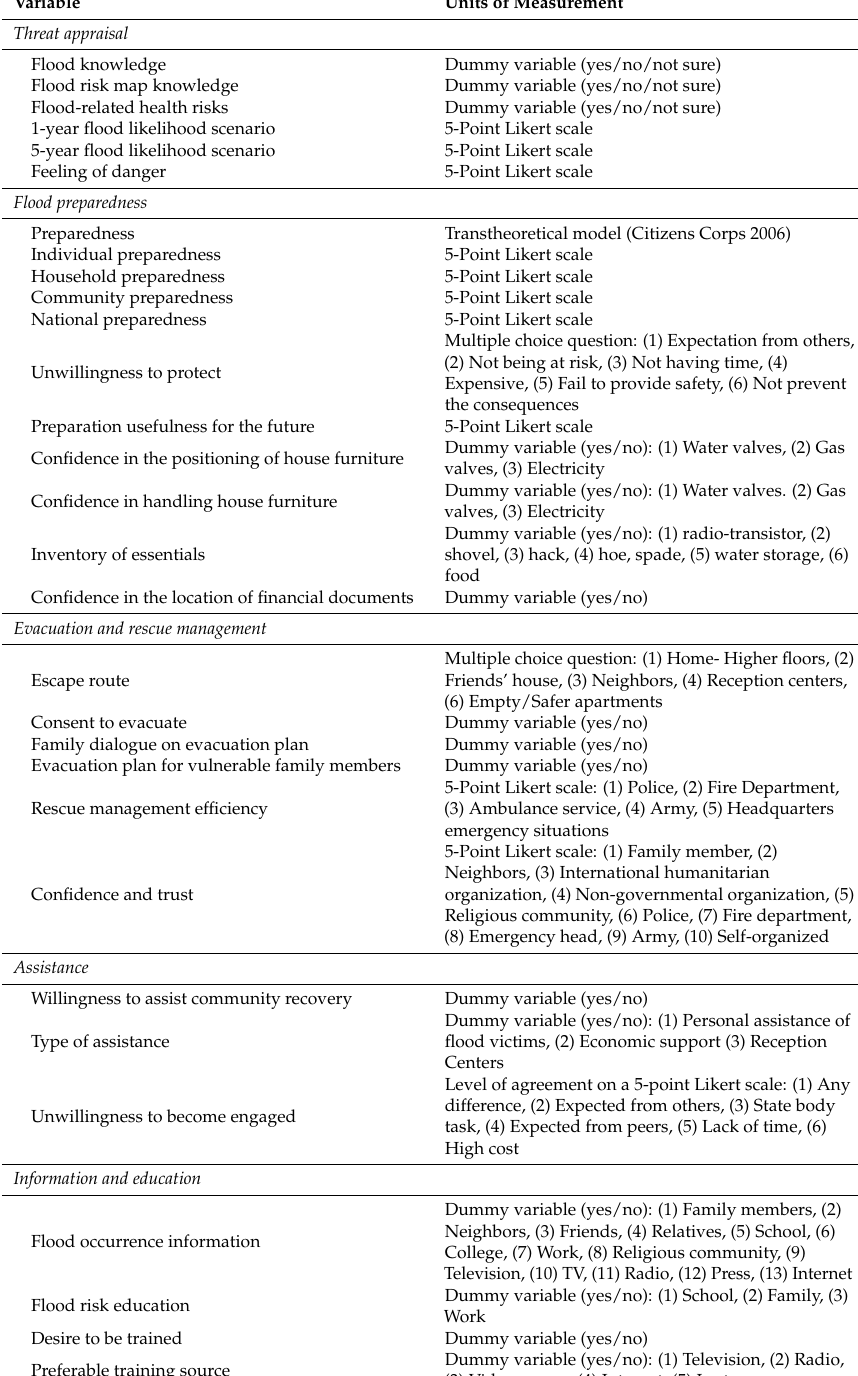
Table A1. Set of questionnaire variables and units of